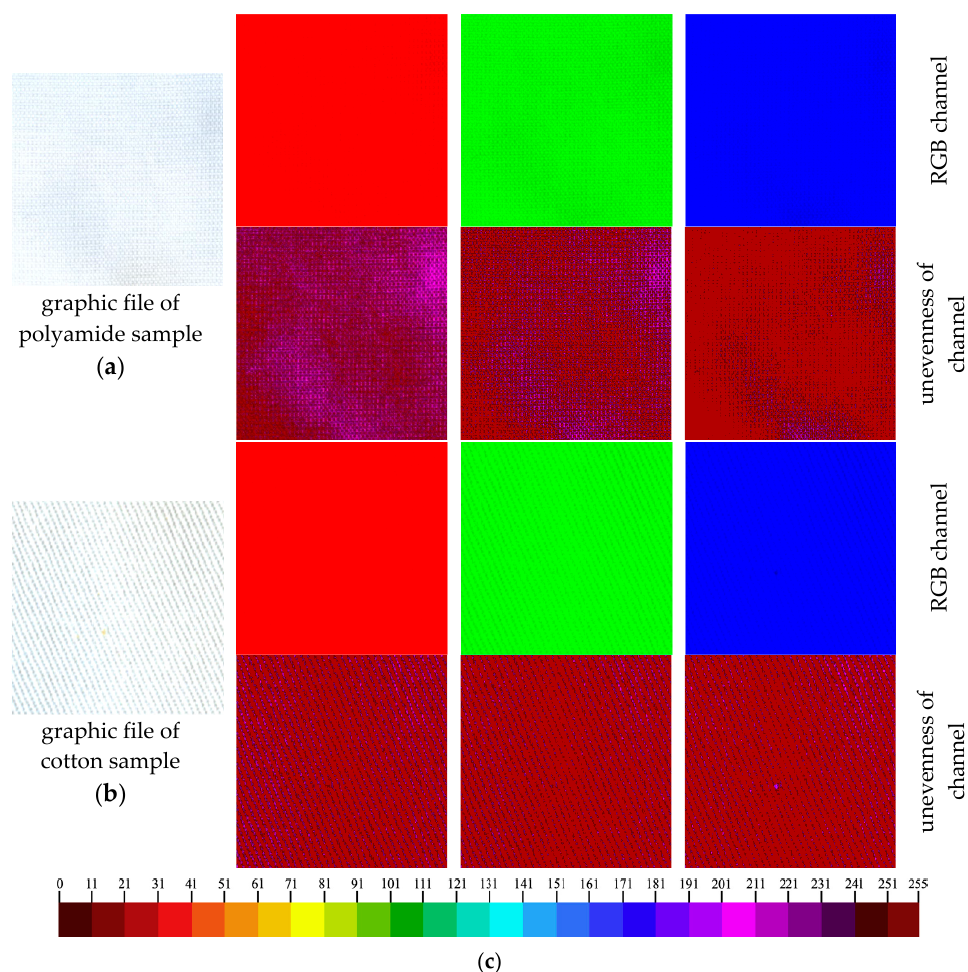
Figure 6. ( a , b ) Non-printed polyamide ( a ) and cotton ( b ) fabrics after RGBreader analysis; ( c ): The scale for the assessment of the unevenness of the RGB channel on the textiles’ surface (RGB values 0: ideal black; 255: ideal white) [20].